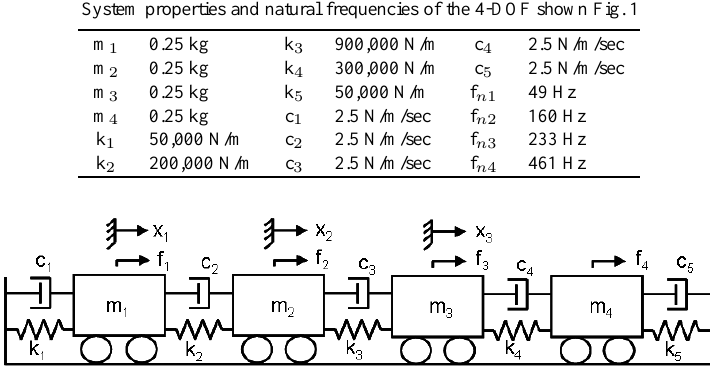
Fig. 1. Four-degree-of-freedom model with underdetermined system of equations of motion.